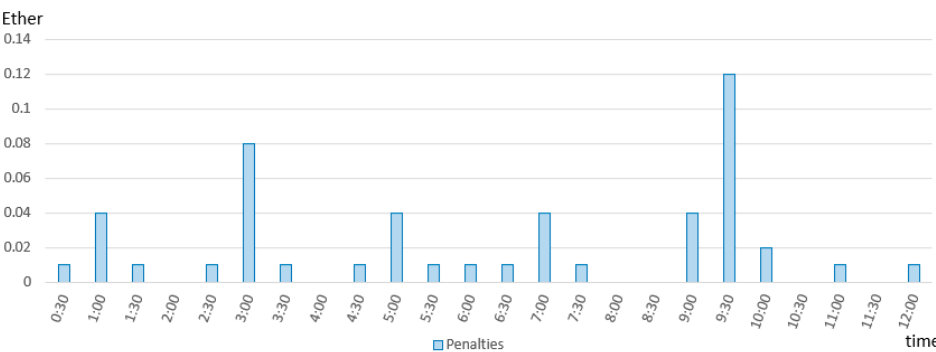
Figure 10. BRP’s financial payment due to registered energy imbalances.